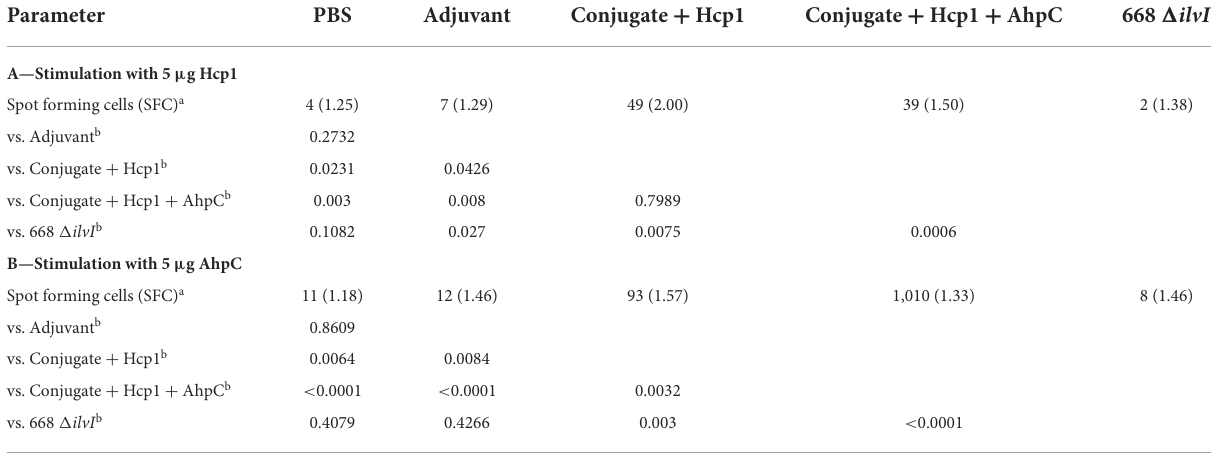
TABLE 4 IFN γ -secreting splenocytes detected after stimulation 6 days post-vaccination (day 44) with Hcp1 or AhpC.